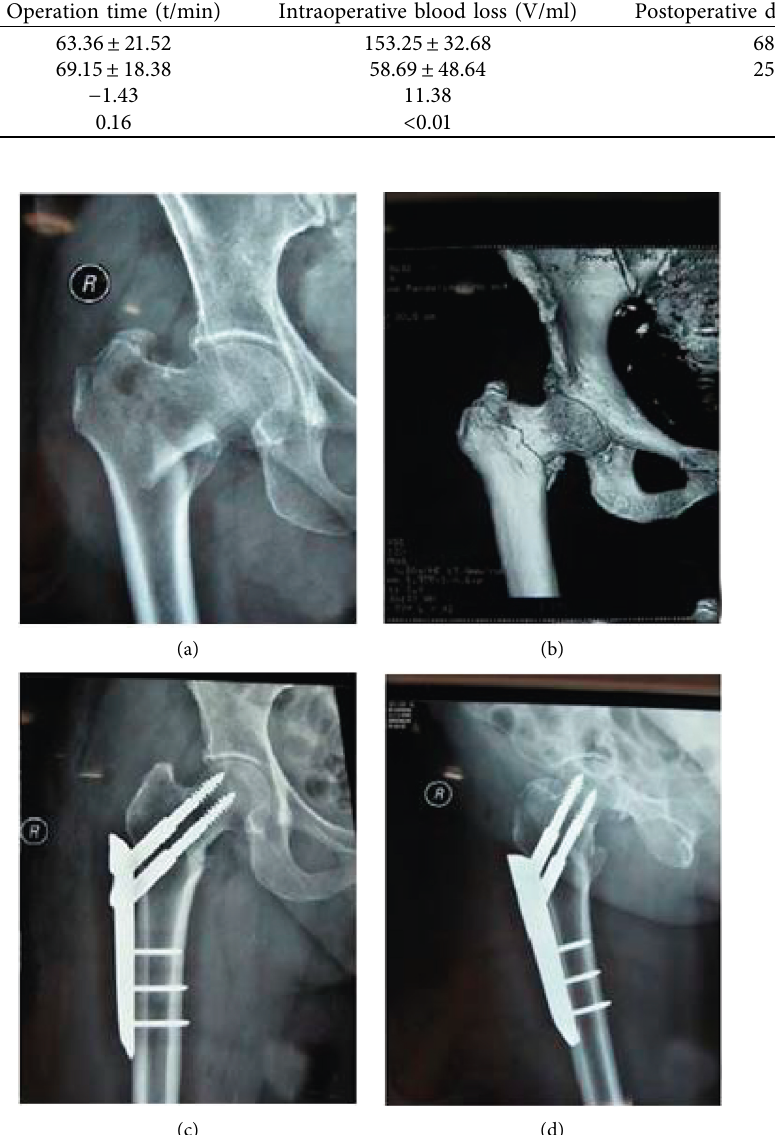
Figure 1: Preoperative and postoperative X-ray images of left femoral intertrochanteric fracture with PCCP. (a) Preoperative left hip joint frontal radiograph. (b) Preoperative 3D CTreconstruction. (c) PCCP postoperative left hip joint frontal radiograph. (d) PCCP postoperative left hip joint lateral